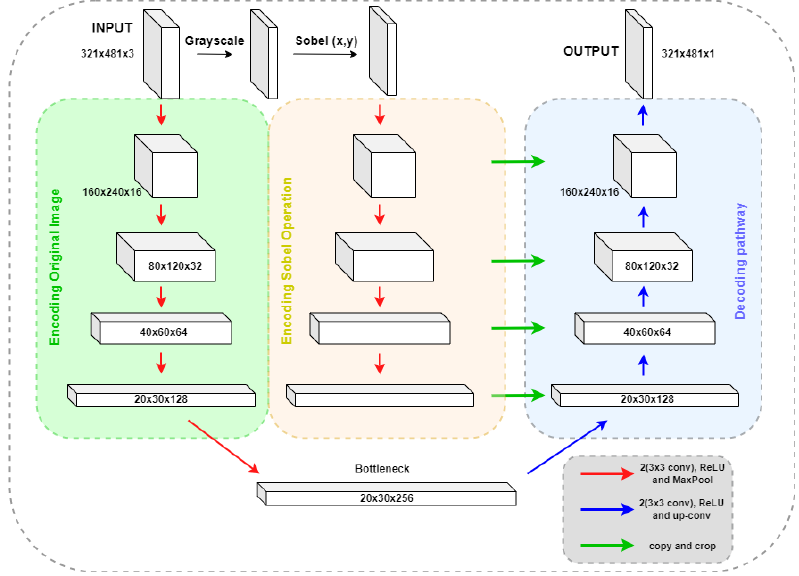
Figure 3. Architecture of SobelU-Net.